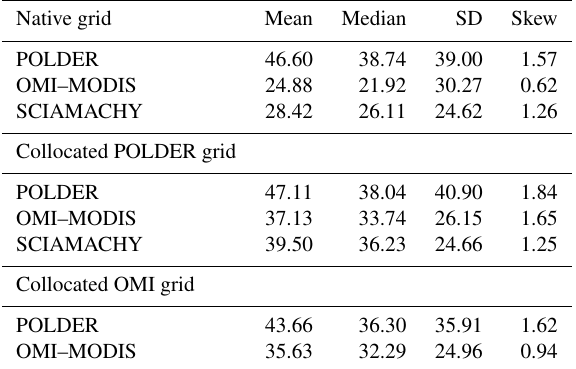
Figure 3. (a) Histograms of aerosol DRE over clouds in the Atlantic Ocean during June–September 2006 from POLDER AOT and COT retrievals (red), combined OMI–MODIS reflectance spectra (black) and SCIAMACHY reflectance spectra (blue). (b) Same as (a) but for collocated POLDER, OMI–MODIS regridded to POLDER grid and SCIAMACHY regridded to POLDER grid pixels only. (c) Same as (a) but for collocated POLDER regridded to OMI grid and OMI–MODIS pixels only. Table 3. DRE statistics of the different instruments before and after collocation for the area 10 ◦ N–20 ◦ S, 10 ◦ W–20 ◦ E in the south-east